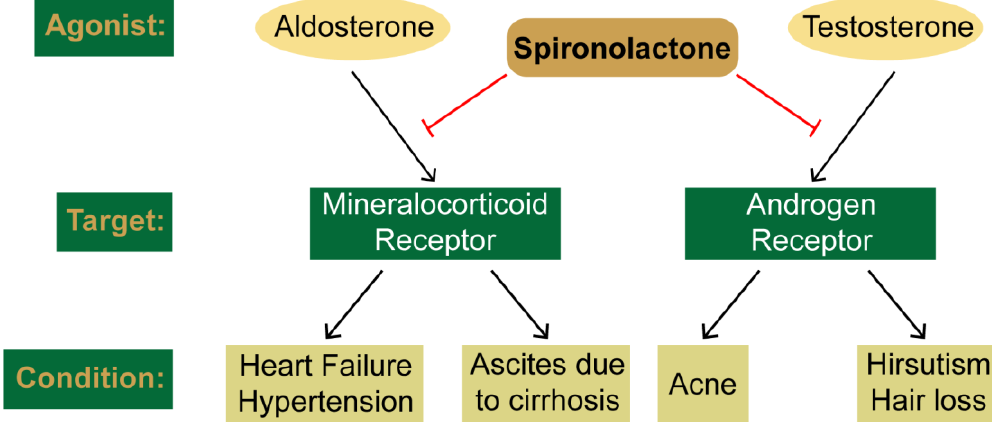
Figure 1. Traditional targets of spironolactone. Spironolactone antagonizes the actions of the aldosterone and testosterone towards their target receptors, the mineralocorticoid and androgen receptors, respectively. Inhibition of these receptors in used to treat the indicate conditions.